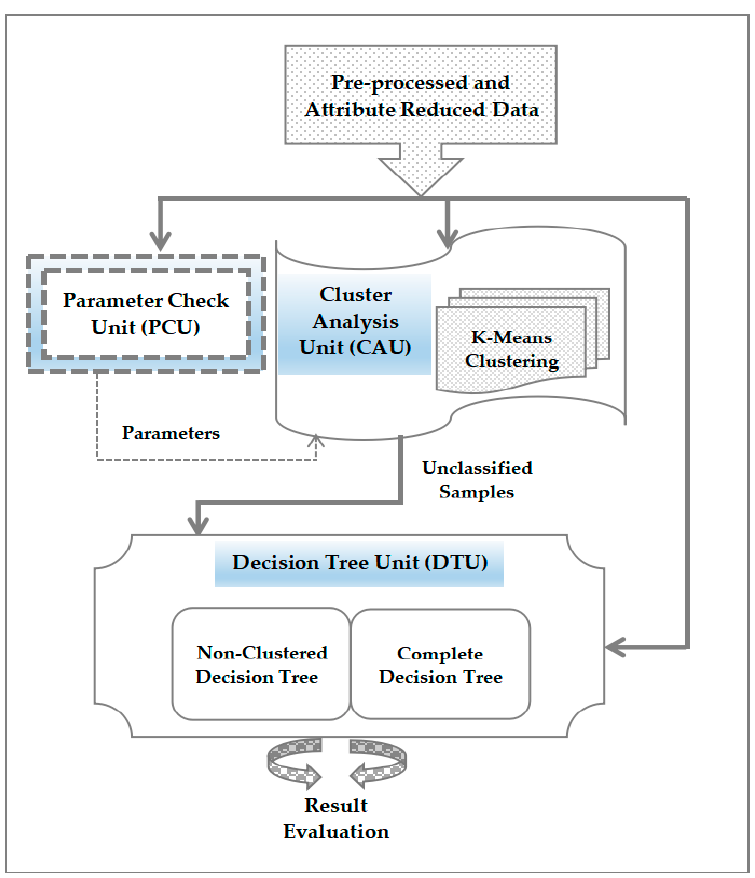
Figure 14. Functioning workflow of Improved decision Tree Model.